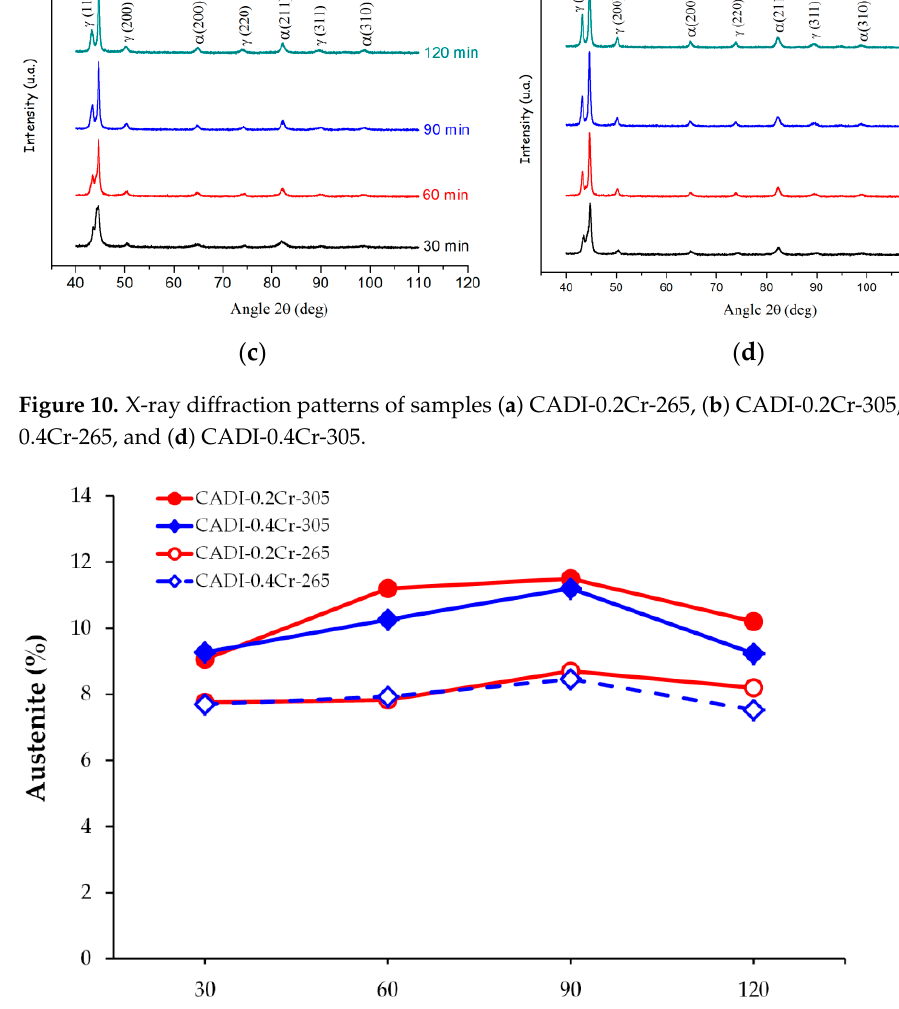
Table 3. Mechanical properties of the ductile irons unalloyed and alloyed with 0.2 and 0.4% Cr. Mechanical Properties